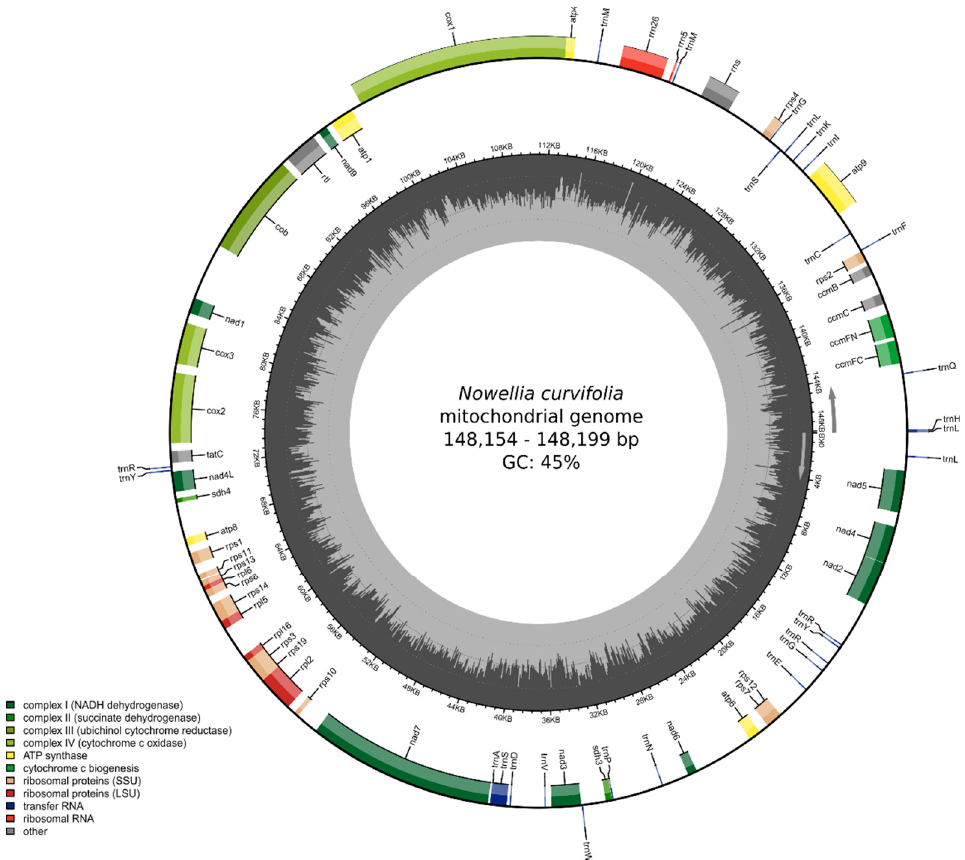
Figure 2. Gene map of the mitochondrion of Nowellia curvifolia . Genes inside and outside the outer circle are transcribed in counterclockwise and clockwise directions, respectively. The genes are color-coded based on their function. The inner circle visualizes the G/C content.